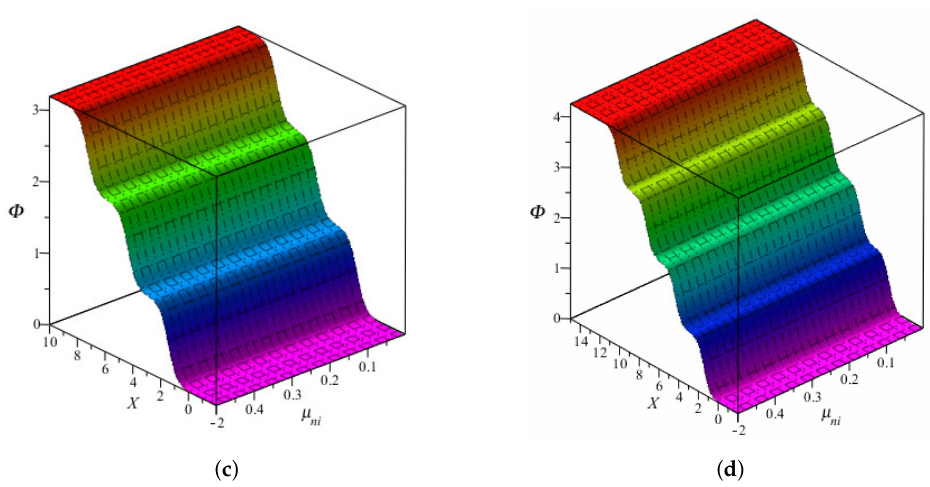
Figure 3. Effect of µ ni on the electrostatic ( a ) single-, ( b ) overtaking collision of double-, ( c ) overtaking collision of triple-, and ( d ) overtaking collision of four-shock wave excitations, respectively, by choosing α = 0.3, q = 0.35, M r = 3.75, T ni = 0.05, T e = 0.2, N r 1 = 0.5, N r 2 = 0.02, µ pi = 0.5, and T =